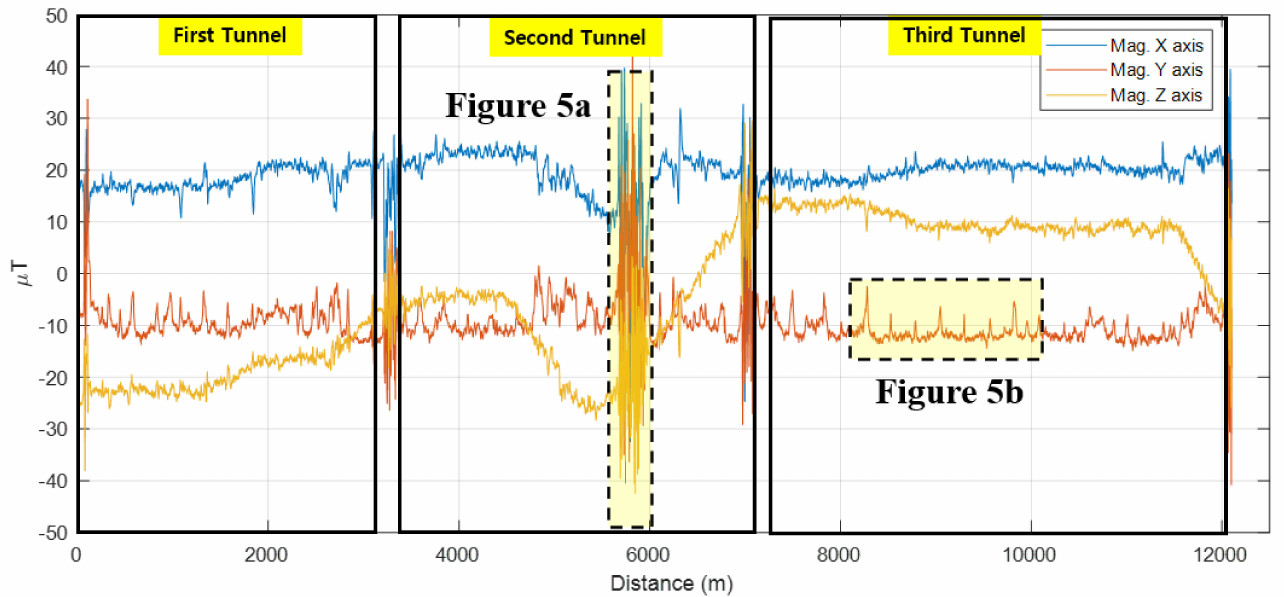
Figure 4. Magnetic field value in the tunnel.